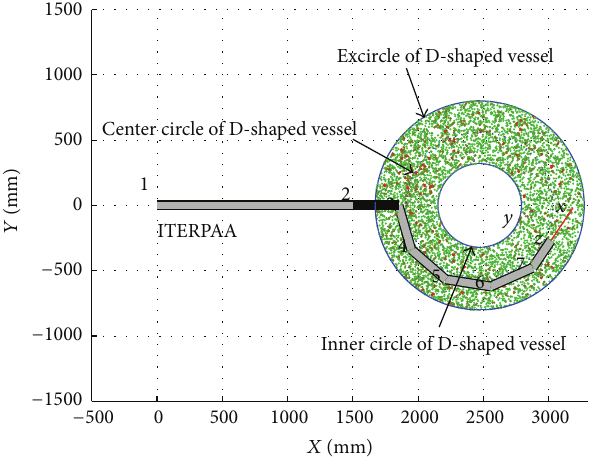
Figure 6: Workspace of the PAA in the horizontal plane inside the D-shaped vessel.